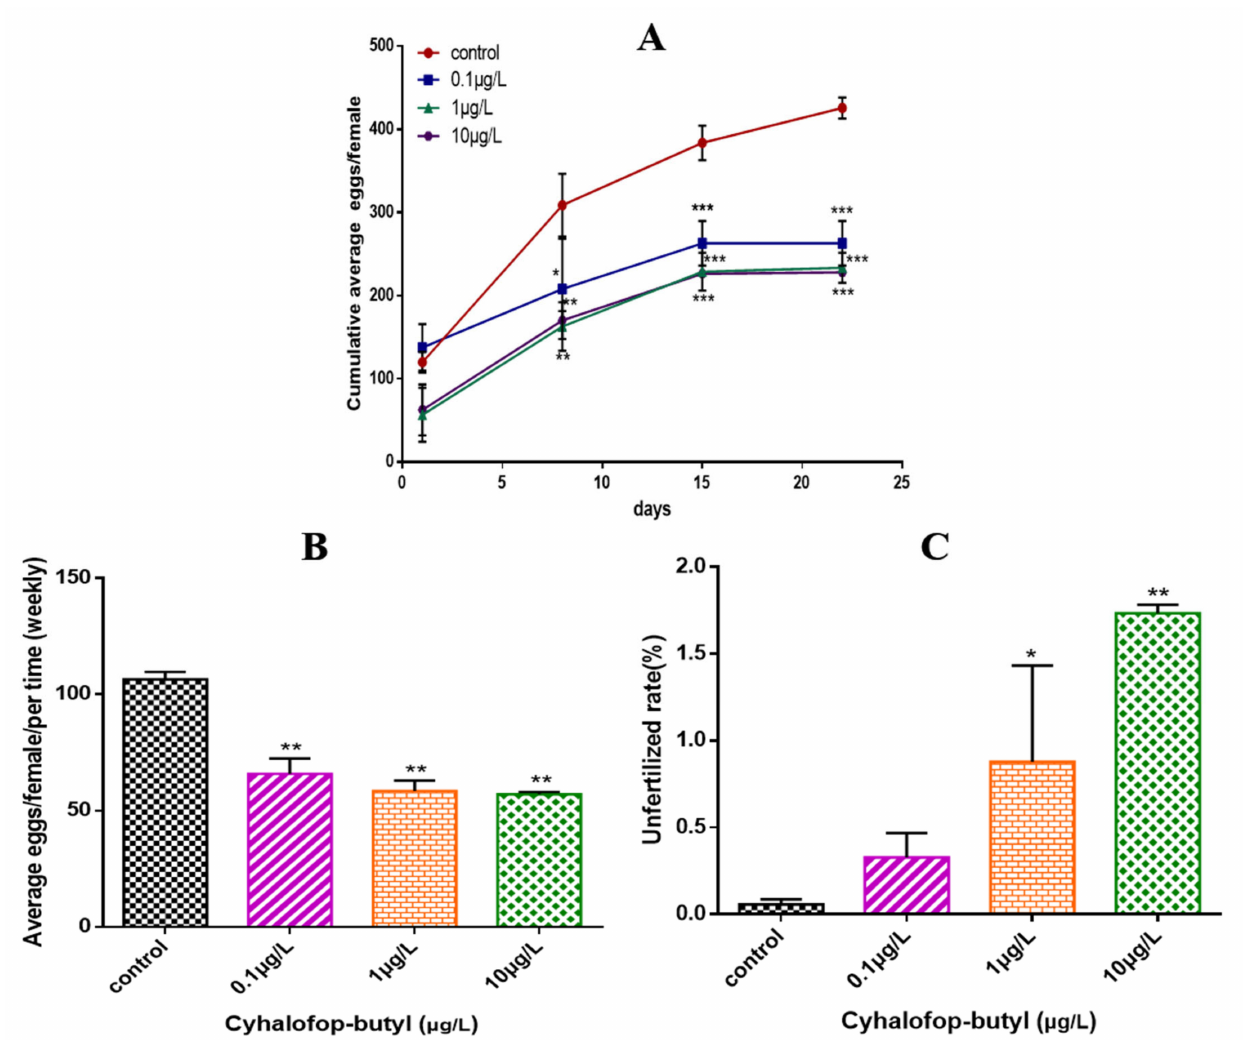
Figure 2. Effects of CyB on the fertility of zebrafish. ( A ) Cumulative average number of eggs per female. ( B ) Average number of spawning eggs per female and per week. ( C ) Rate of unfertilized eggs during the 150 d of exposure. The rate of unfertilized eggs was calculated as the cumulative number of unfertilized eggs × 100/total spawning eggs. Values are shown as the mean ± SD of three replicates per treatment (* p < 0.05; ** p < 0.01; *** p <